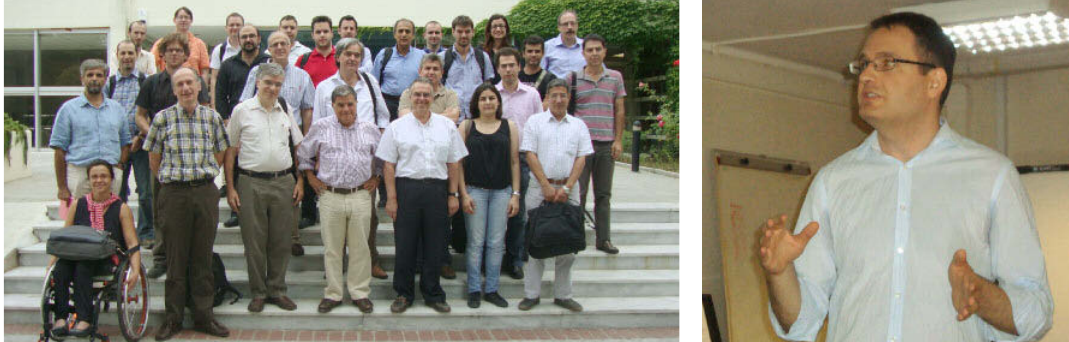
Figure 1 (left): A souvenir photograph of the HSR 2011 participants in front of Demokritos Convention Center, in Athens, Greece. Figure 2: Yannis Dimakopoulos presents his plenary lecture on hemodynamics of the heart seen through numerical simulations. © Appl. Rheol. 21 (2011)